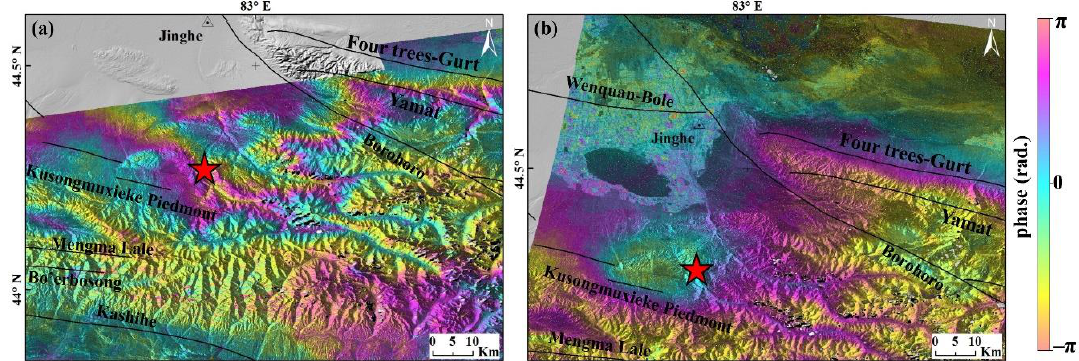
Figure 2. Examples of interferograms affected by strong atmospheric signals, where red stars denote the epicenter of the Mw 6.3 Jinghe earthquake. ( a ) Wrapped interferogram from ascending track T12 (4 June 2017 – 15 August 2017); ( b ) wrapped interferogram from descending track T165 (8 August 2017 – 1 September 2017). The scale per one color-cycle is 2π.